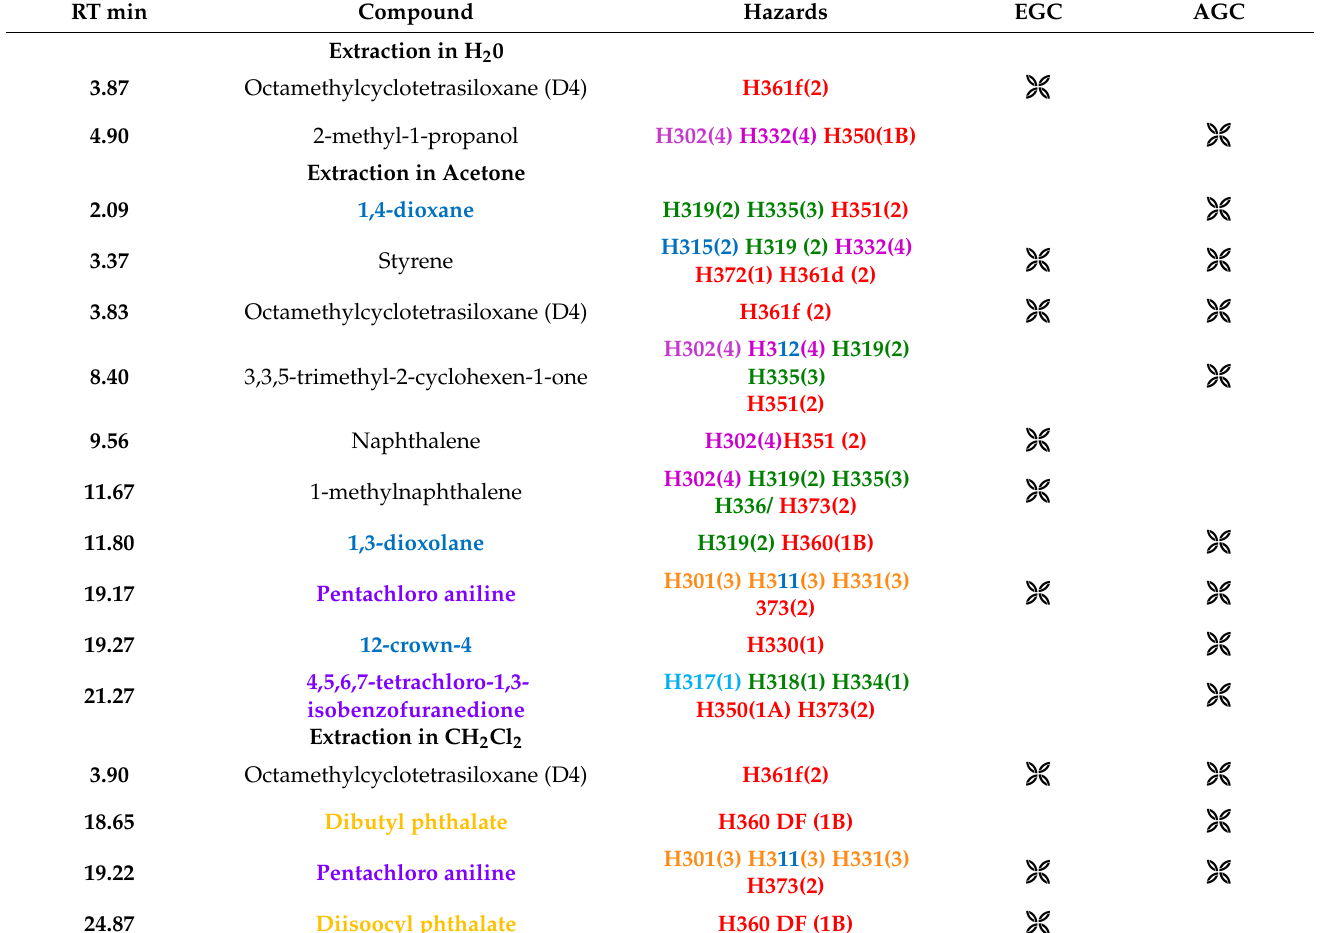
Table 2. Selection of the most hazardous compounds extracted in water, acetone and CCl 2 H 2 , and corresponding hazard codes. Chlorinated compounds are reported in violet , phthalates in orange and peculiar compounds of AGC in light blue . The colours assigned to different hazards indicate: Red = lethality , Orange = Toxicity , Pink = Harmfulness , Bluish = skin related issues , Green = irritation, damage, drowsiness .